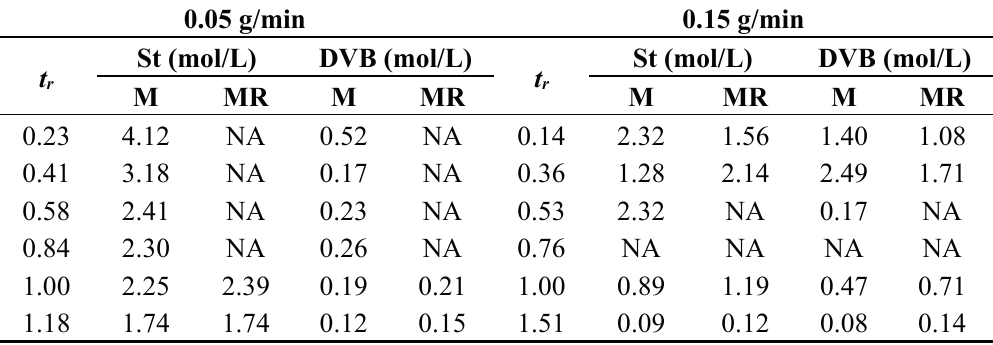
Table 2. Monomer concentration in particles along polymerizations as function of organic phase dosing